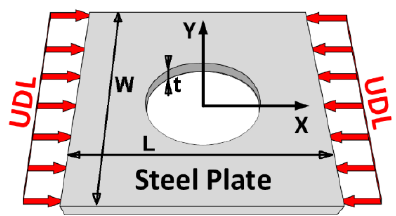
Figure 1. Uniaxial loaded steel plate with a centrally placed circular opening under uniformly distributed loading (UDL).